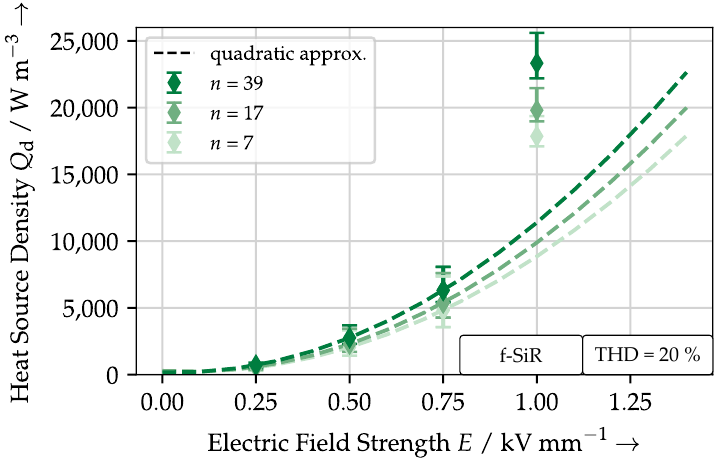
Figure 10. Heat source density of f-SiR as a function of the electric field strength under distorted voltage THD = 20%, quadratic approximation for E = ( 0.25 ... 0.75 ) kVmm − 1 , the mean and range of three test objects.